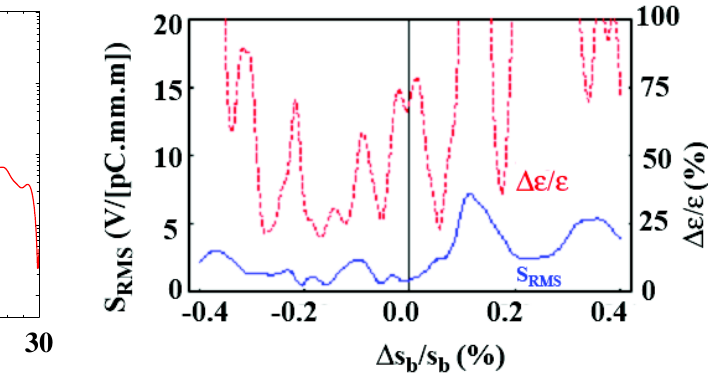
FIG. 11. (Color) Vertical transverse wakefield amplitude in the pair of dipole-mode interleaved accelerator structures. The solid red line is the predicted wakefield and the data points are the experimental